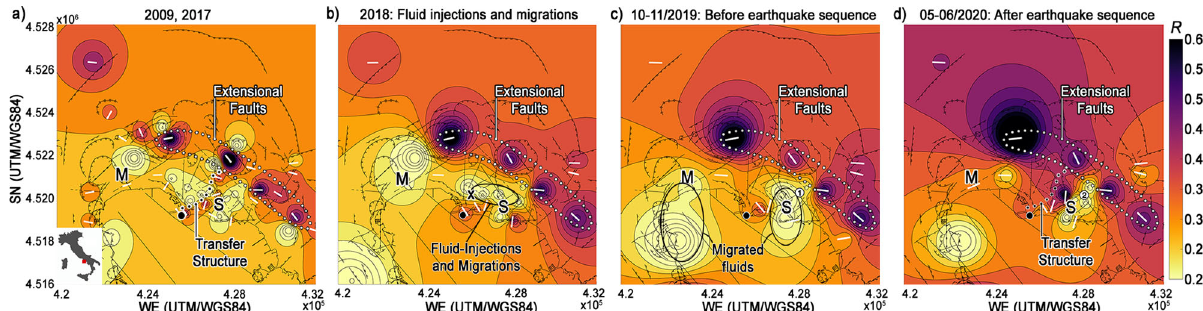
Fig. 1 Maps of resultant lengths and azimuths from ambient noise at Campi Flegrei. a The resultant length ( R ) is plotted with a squared interpolation from each station between 0.2 and 1 Hz during periods of low seismic release (2009, 2017). The continuous white segments show the corresponding azimuths (only for R > 0.25). The patterns are imposed over mapped fault strikes, fractures, and craters 24 – 26 . The Solfatara crater (S) and Monte Nuovo (M) are marked on the maps. The wide black dot is the stationary point of maximum vertical deformation for the last 36 years 27,31 . The dotted black line marks the transfer structure ( R > 0.31). The dotted white line contours the portion of the NW-SE extensional faults that shows R > 0.5 and the same azimuths over a decade. b Same map obtained using noise recorded over six months in 2018. The black cross shows the centre of the high-attenuation anomaly in Fig. 2a. Part of the transfer structure depolarizes due to fl uid injections and migrations (black ellipse). c Same map obtained using two months of noise recorded before the Md3.1 earthquake (December 6 th , 2019, circled number 1) after fl uids migrated to the east and west reservoirs. d Same map obtained using two months of noise after the Md3.3 earthquake (April 26 th , 2020, circled number 2), when the transfer structure